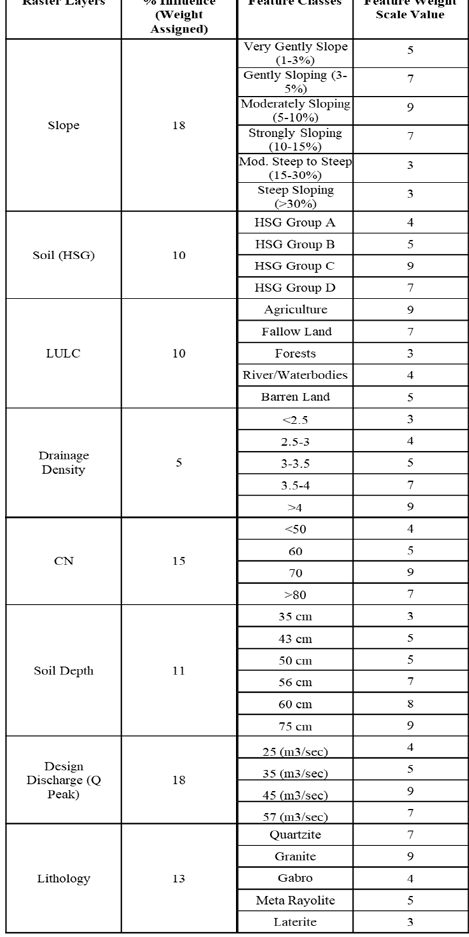
Table 2: Weight and scale value given to different